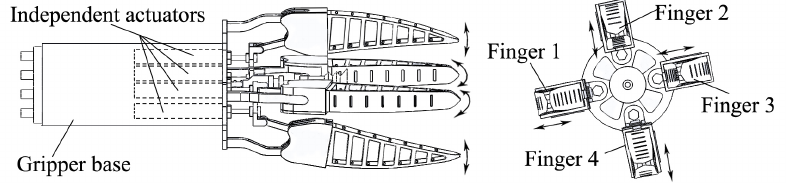
Figure 1. Mechanical